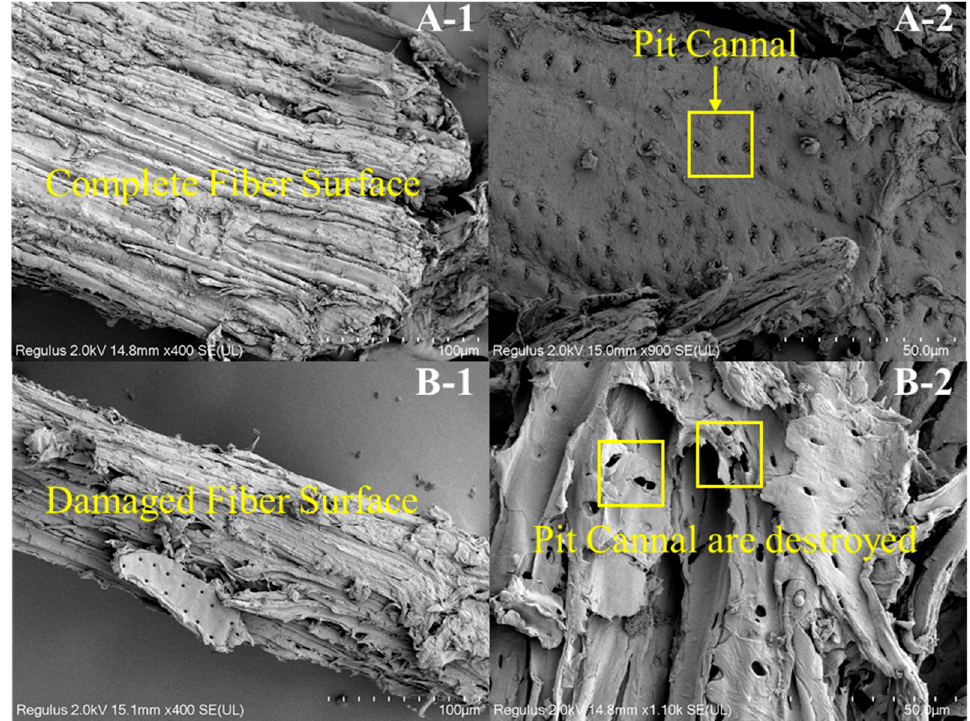
Figure 3. Photos of pulp at holding times 0 min ( A ) and 60 min ( B ). The specific scale bars with 100 μ m (1) and 50 μ m (2) are shown in the SEM images.